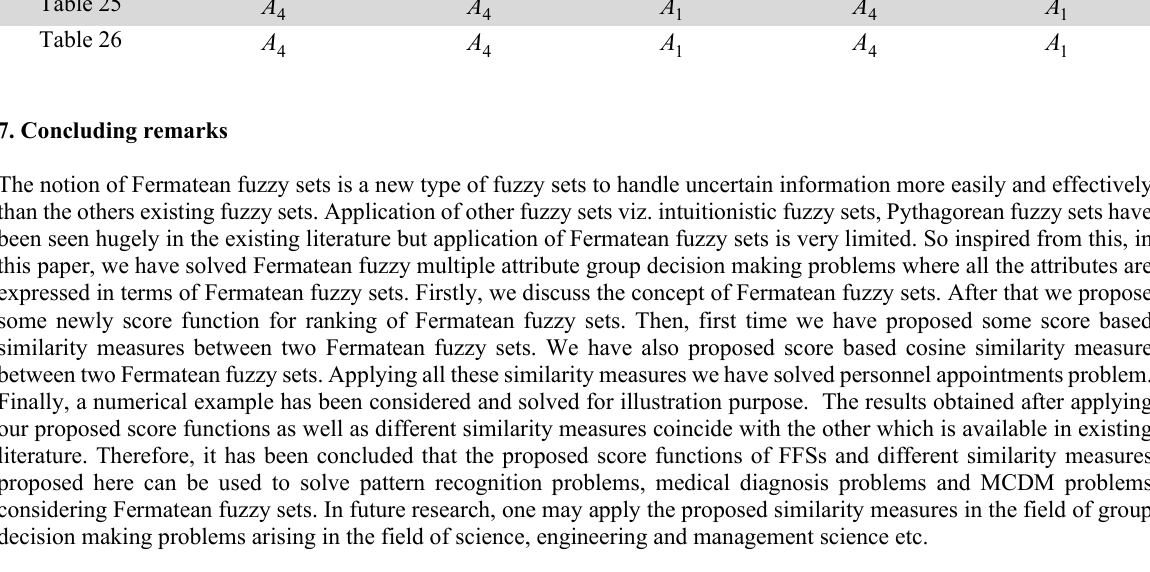
A 1 A 1 A 1 A 1